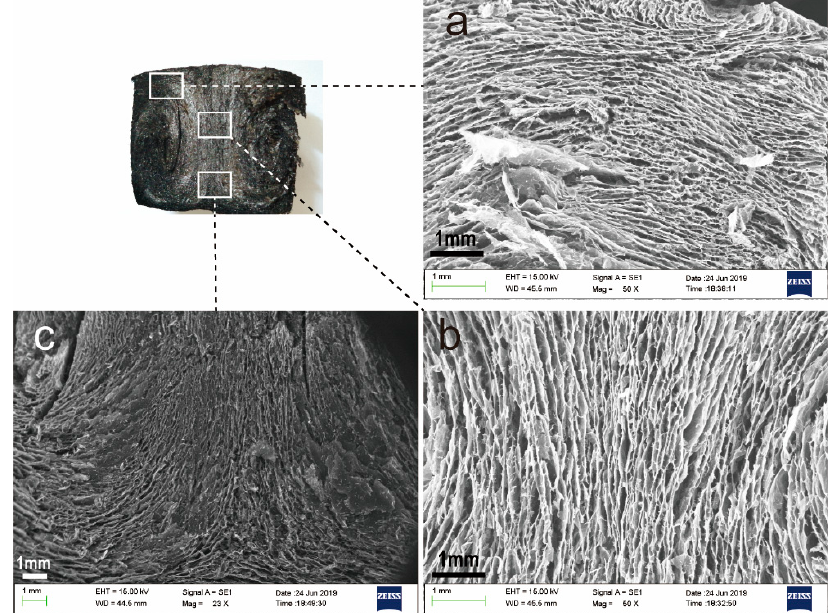
Figure 2. The scanning electron microscopy (SEM) images of AGA. ( a – c ) are electron microscope images of different positions in the longitudinal section of AGA.